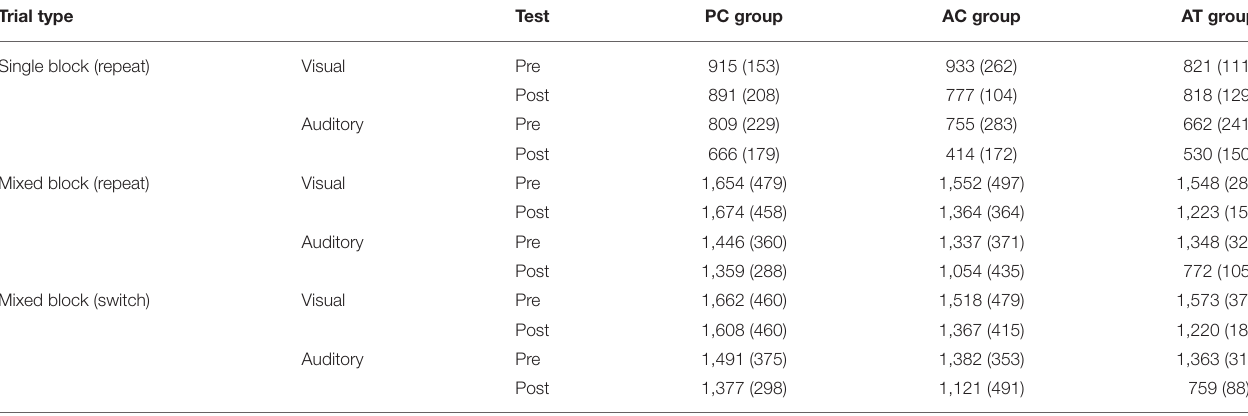
TABLE 1 | Mean RTs (ms) in the task switching assessments at pre- and post-test, for the average of the two single task blocks with repeat trials, the average of repeat trials in the mixed block, and the average of the switch trials in the mixed block in old adults.